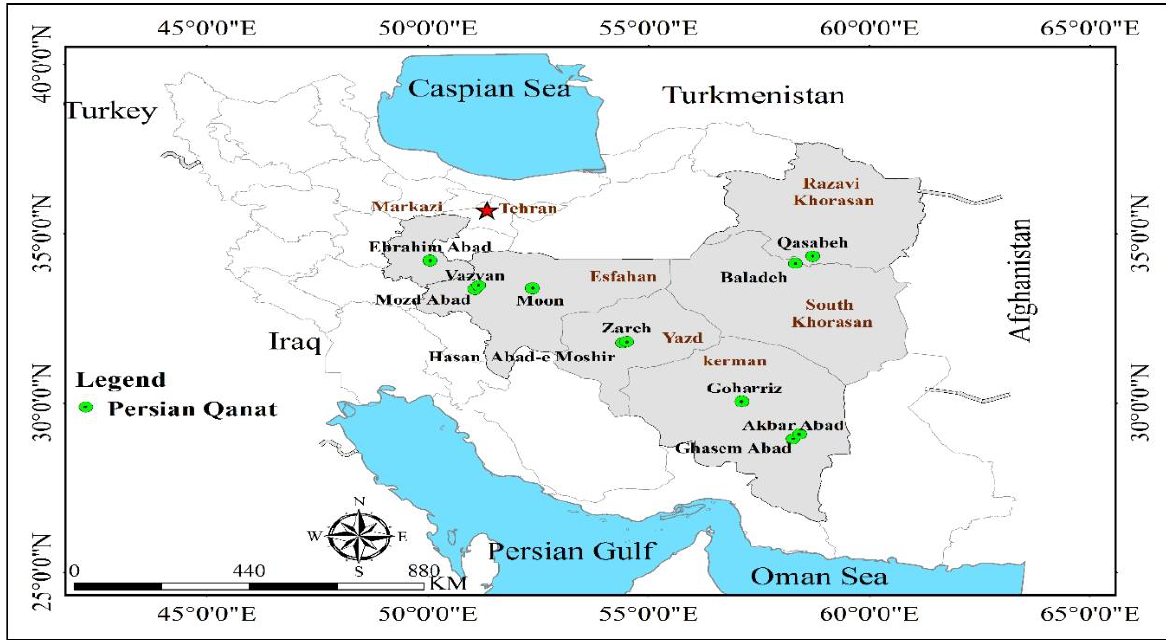
Figure 2. Study sites. Figure 2. Study Table 1. PQs listed as UNESCO World Heritage properties.